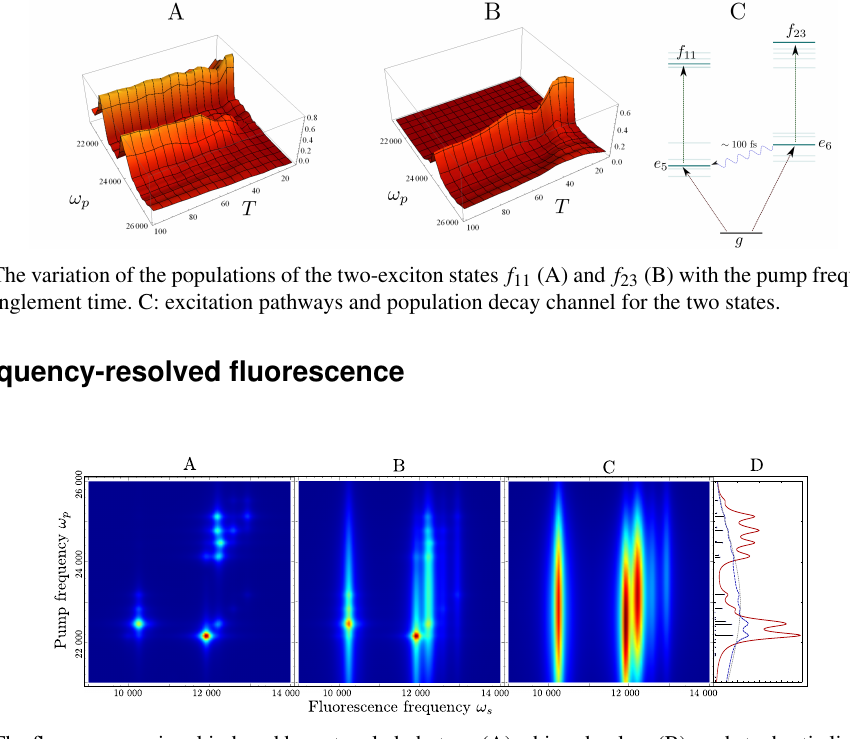
Fig. 4. The fluorescence signal induced by entangled photons (A), chirped pulses (B), and stochastic light (C). D: The fluorescence action spectrum of entangled photons (solid line), chirped pulses (dashed), and stochastic light